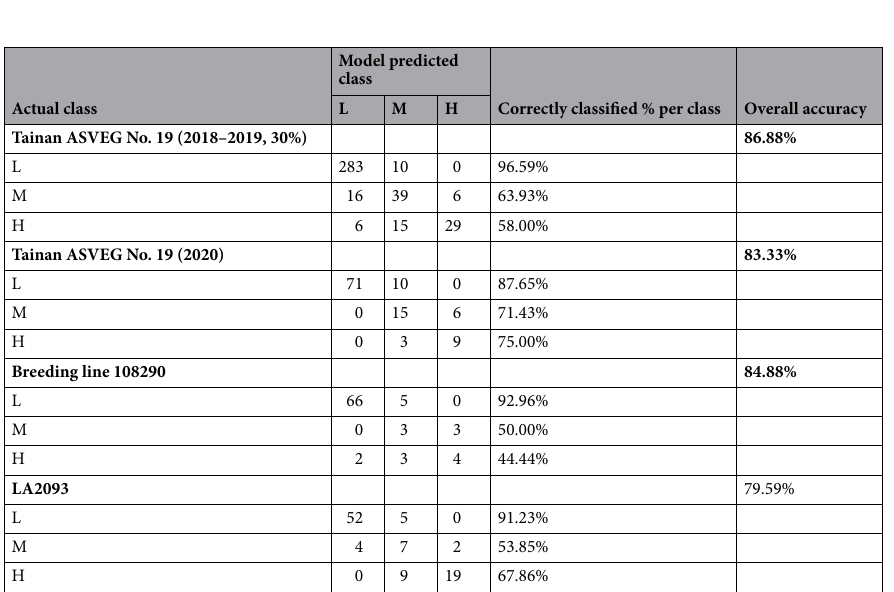
Table 6. Confusion matrix for the classification and regression tree model (multi-class). Values that meet acceptable standards are shown in bold. L: low stress, with g sw ≧ 0.15 mol H 2 O m −2 s −1 ; M: medium stress,